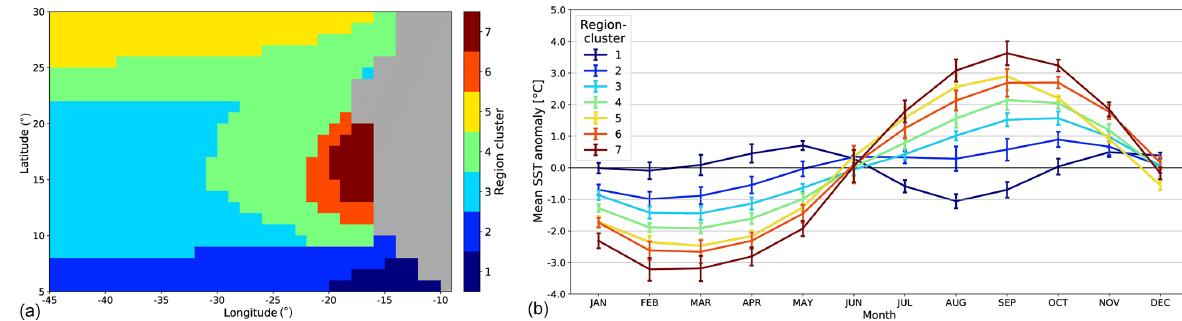
Figure 2. (a) Region clusters associated with the SOM clusters obtained after a HAC on a 30 × 4-neuron SOM learned on ERSSTv3b observations in the extended zone (see text for details). (b) Ensemble-mean monthly climatological SST anomalies for the grid points of the seven region clusters. The error bars show the standard deviation of this ensemble mean.